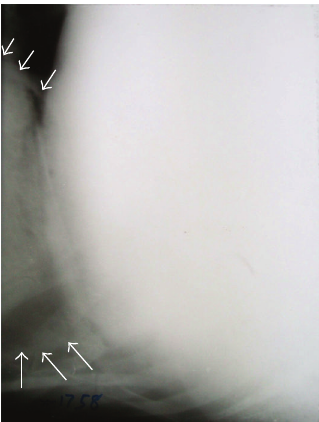
Figure 5: Lateral radiograph of reticulum showing indistinct diaphragmatic line. Metallic densities (hollow arrows) seen inside thoracic cavity. Note the gas density (black arrows) having embed- ded metallic density suggesting reticular